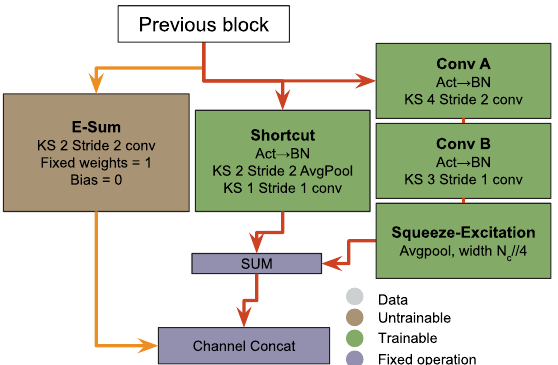
Fig. 4 Diagrams illustrating the three types of blocks used to construct the convolutional heads